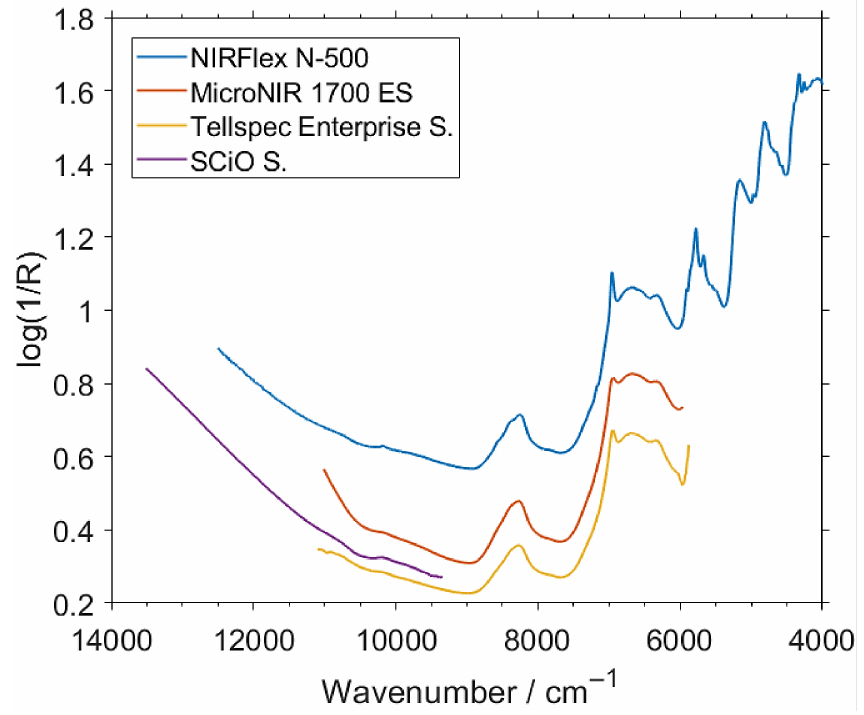
Figure 1. Unpretreated NIR (near-infrared) spectra of exemplary intact samples measured by the spectrometers involved in this